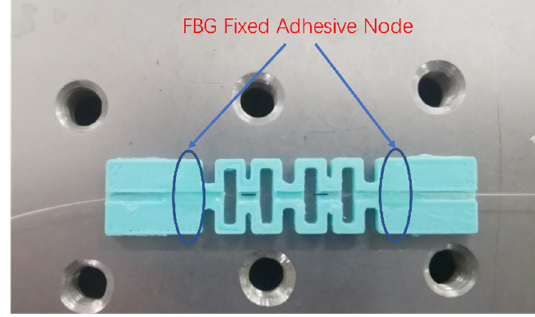
Figure 12. Picture of PLA-AE-FBG2 sensor.